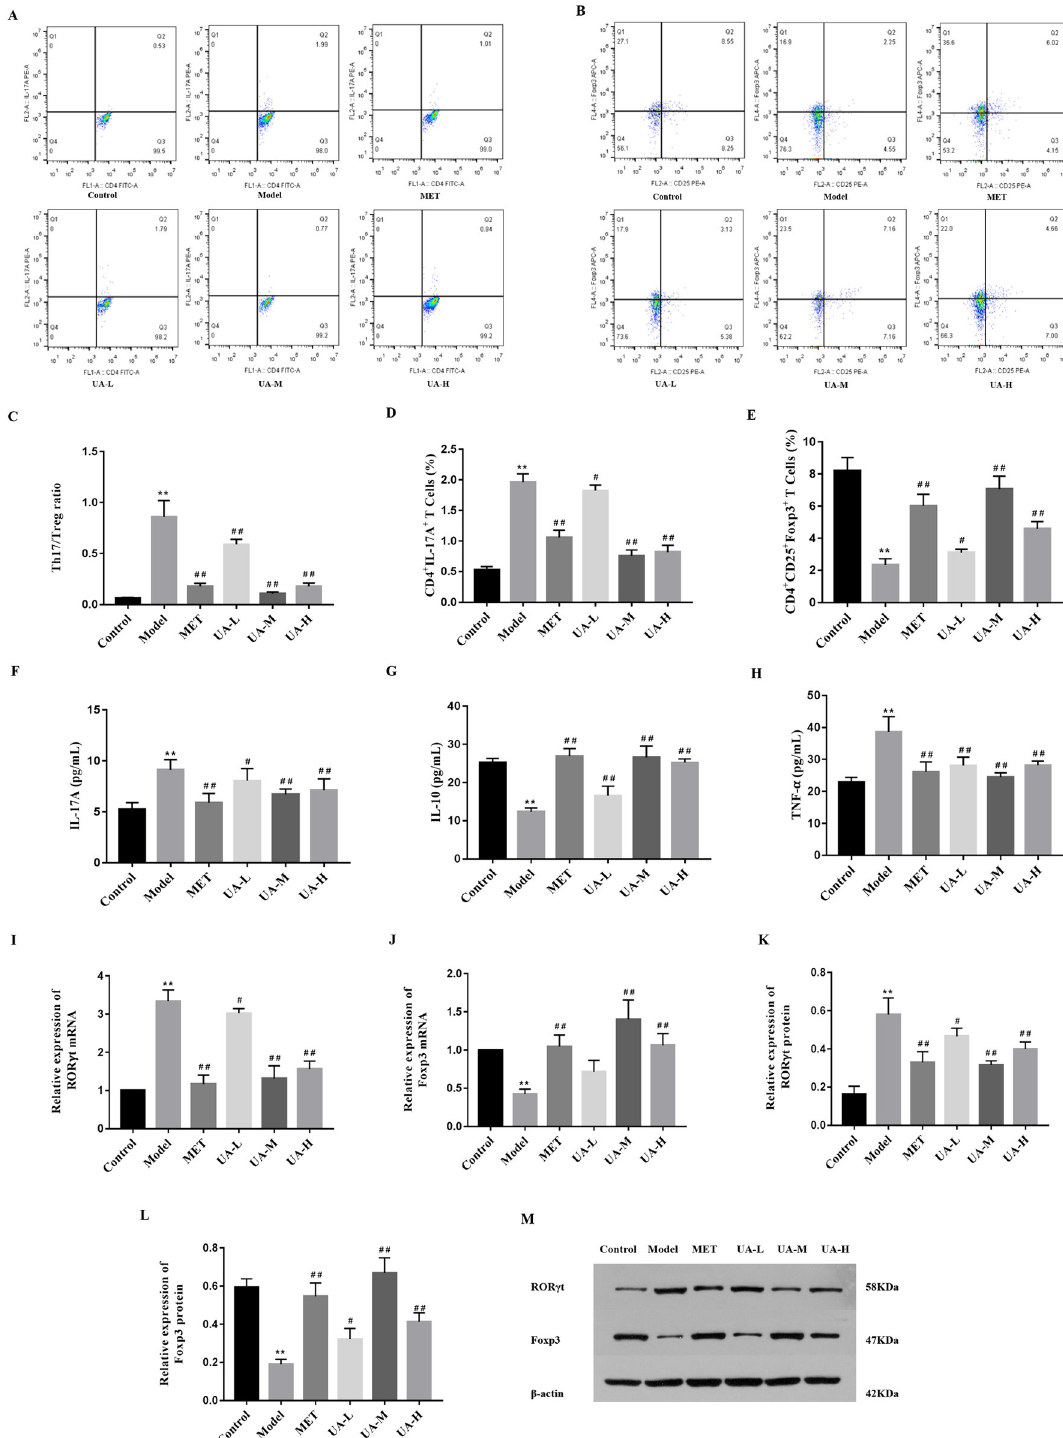
Fig 3. UA treatment corrected the proportion of Th17 and Treg cells in rat with T1DM. (A) CD4 + IL-17A + (Th17) cells and (B) CD4 + CD25 + Foxp3 + (Treg) cells in the spleen from the six groups were analyzed by flow cytometry. (C) The Th17/Treg ratio in the spleen. (D)The percentage of CD4 + IL-17A + (Th17) cells in the spleen. (E) The percentage of CD4 + CD25 + Foxp3 + (Treg)cells in the spleens. (n = 6). ELISA was used to compare the levels of the cytokines IL-17A (F), IL-10 (G), and TNF- α (H) in blood serum between the six groups (n = 8). mRNA expression levels of ROR γ t (I) and Foxp3 (J) in the spleen of the rats were measured by real-time